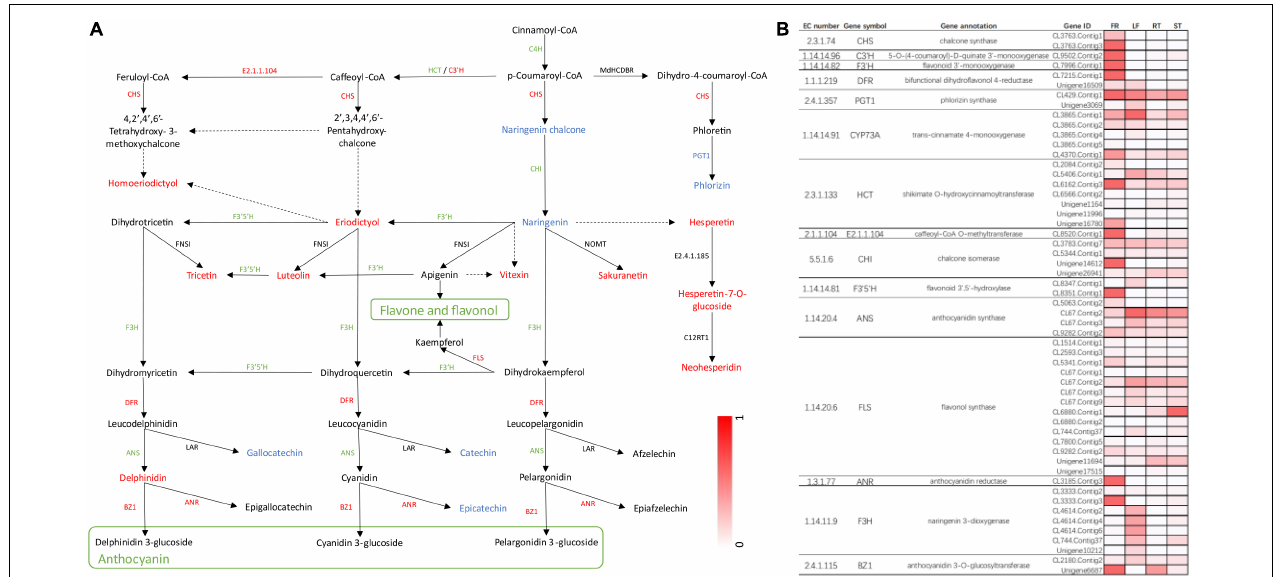
FIGURE 7 | The DEGs and DAMs associated with flavonoid biosynthesis in FR and LF groups of Trapa bispinosa . (A) Flavonoid biosynthesis pathway. The red letters represent up-regulated DEGs and DAMs. The green letters represent down-regulated DEGs. The blue letters represent down-regulated DAMs. (B) Changes in expression of genes involved in flavonoid biosynthesis